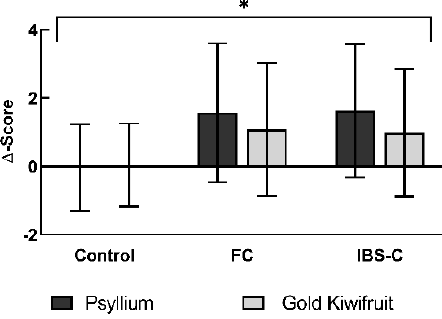
Figure 4. Complete Spontaneous Bowel Movements per week ∆ -score: median score after subtraction of pre-intervention score from post-intervention = relative shift from baseline. Bars: arithmetic means, error bars: 95% confidence intervals. Positive score = increase in symptom, negative score = decrease in symptom. n = 56. Asterisks indicate statistical significance. * = Statistically significant effect of interventions, p = 0.006. FC, Functional Constipation; IBS-C, Constipation-predominant Irritable Bowel Syndrome. Table 4. Differences in Complete Daily Bowel Movement Diary results post – pre-intervention. p -Value Factor ( n = 54)